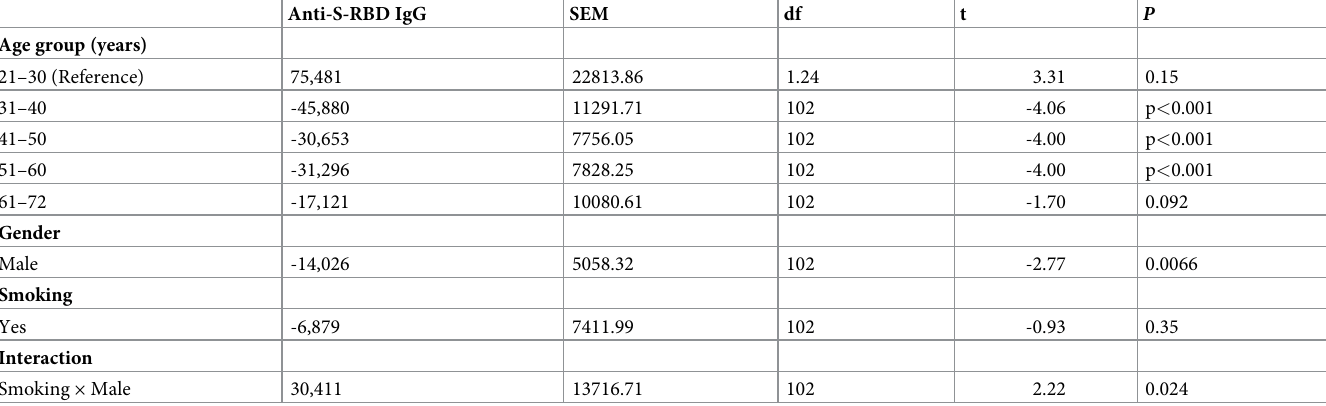
Table 7. Estimated IgG anti-S-RBD titers of the 110 subjects that were included in both study periods by the mixed effects model using the gender and age variables as